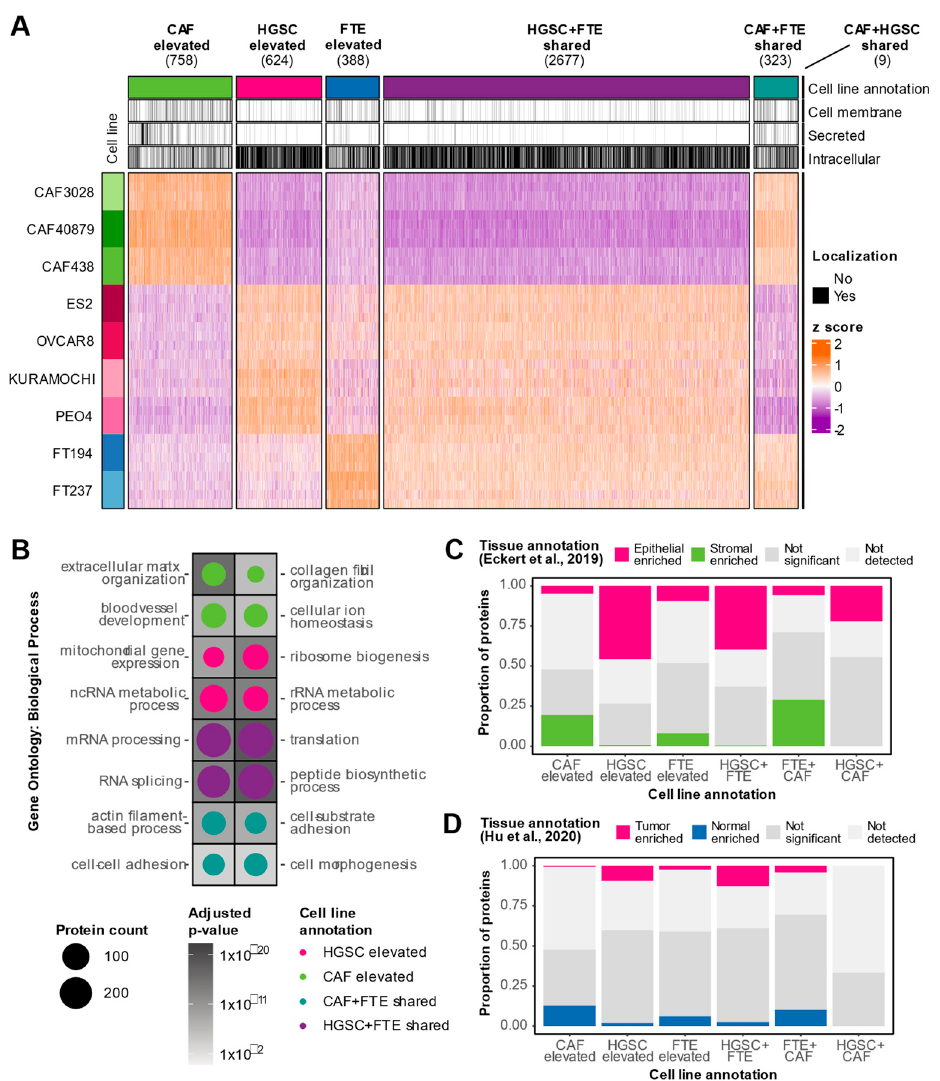
Figure 3. Characterization of in vitro cell type elevated and shared proteins. ( A ) Heatmap visualizing protein expression of cell type elevated (Tukey’s p -value < 0.05 and |log 2 FC| > 1 against two cell types) and shared (Tukey’s p -value < 0.05 and |log 2 FC| > 1 against one cell type) proteins detected in WCL. Covariate bars indicate UniProt subcellular localization keyword annotations. ( B ) Significantly over-represented Gene Ontology: Biological Processes in cell type elevated and shared proteins. Size of the circle represents the number of proteins detected in each cell type classification annotated with the respective term and the shading of the background tile indicates the adjusted p-value. No pathways passed statistical significance for FTE elevated and CAF + HGSC shared cell type annotations. ( C ) Stacked bar plot depicting proportion of cancer epithelial and cancer stromal enriched tissue proteins [18] in each WCL cell type classification group. ( D ) Stacked bar plot depicting proportion of tumor and normal enriched tissue proteins [19] in each WCL cell type classification group.